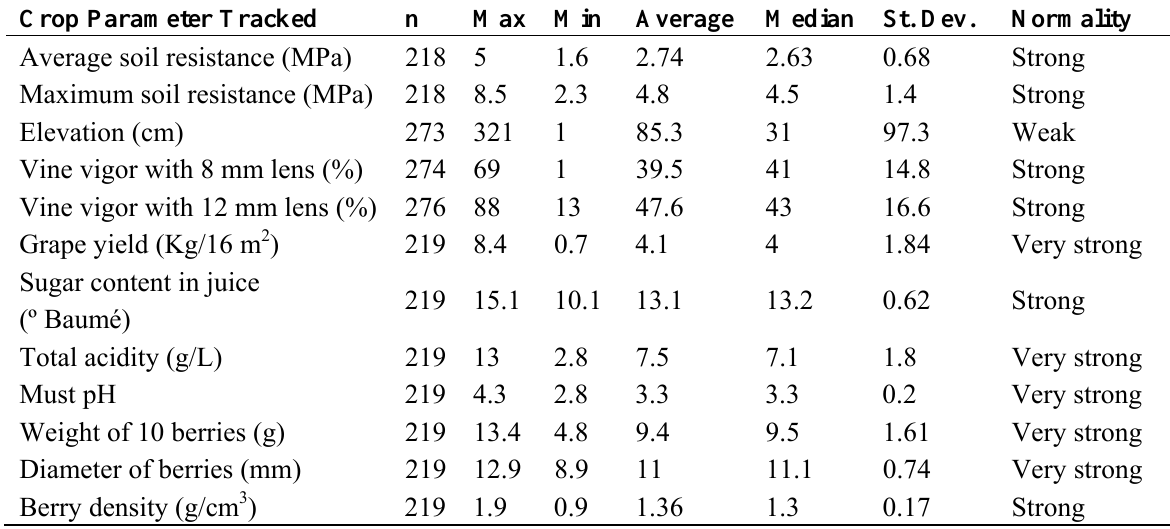
Table 2. Inference statistics for vineyard biometric traits.